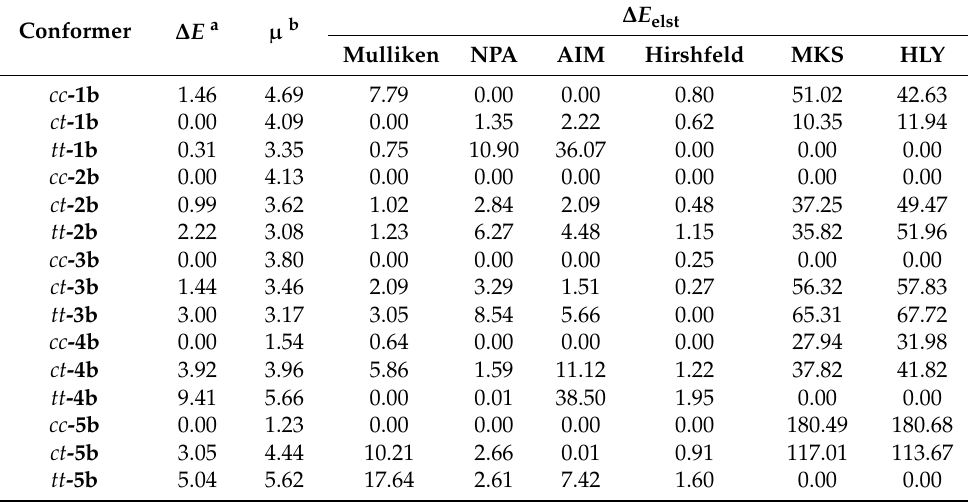
Table 2. Relative electron energies ( ∆ E in kcal/mol), dipole moments obtained from the full density ( µ in Debyes) and relative electrostatic energies ( ∆ E elst in kcal/mol) for 1b – 5b in their three conformations. All the results are calculated at the B3LYP/def2-QZVPP level of